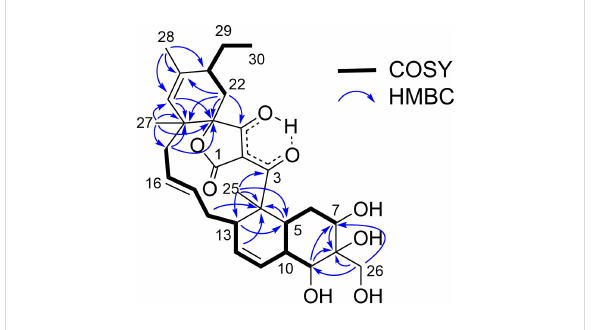
Figure 2: COSY and key HMBC correlations for 1